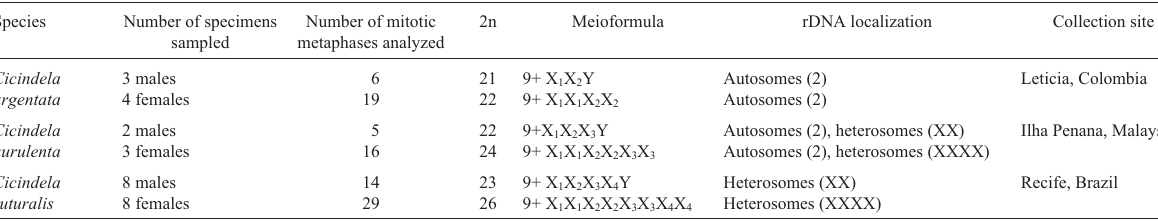
Table 1 - Cytogenetic data and collection sites of the Cicindela species analyzed. Species Number of specimens Number of mitotic 2n Meioformula rDNA sampled metaphases analyzed